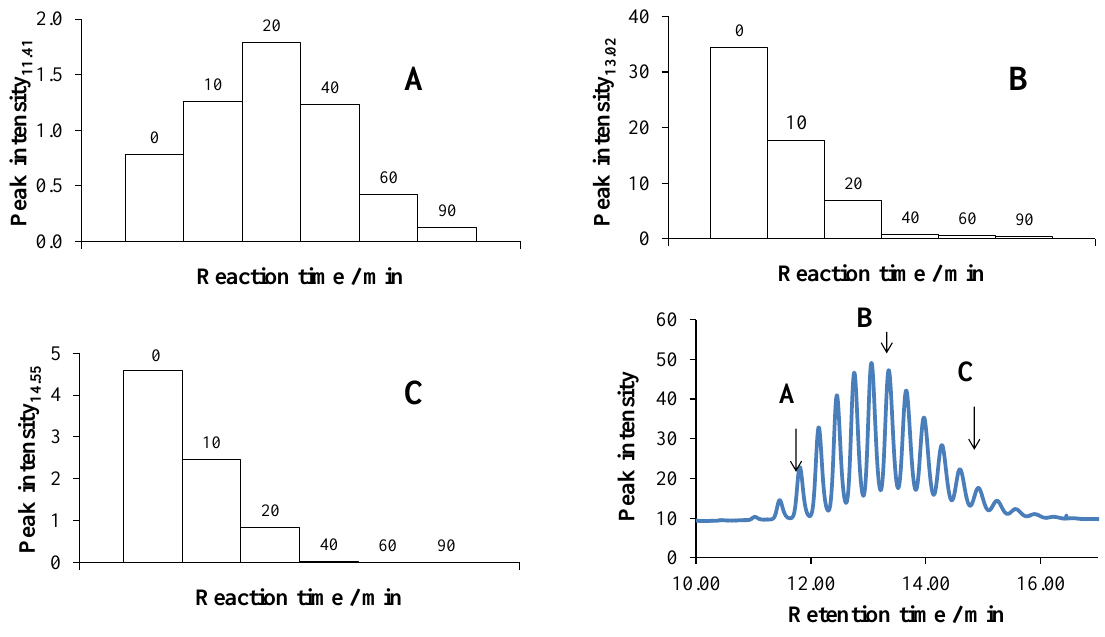
Figure 12. The change of the peak intensity as a function of the reaction time from the UHPLC chromatograms obtained during the photocatalysis of the system containing 2 × 10 −4 mol·dm −3 Triton X-100 and 1 g·dm −3 TiO 2 : at a retention time of 11.41 min ( A ), 13.02 min ( B ) and 14.55 min ( C ).